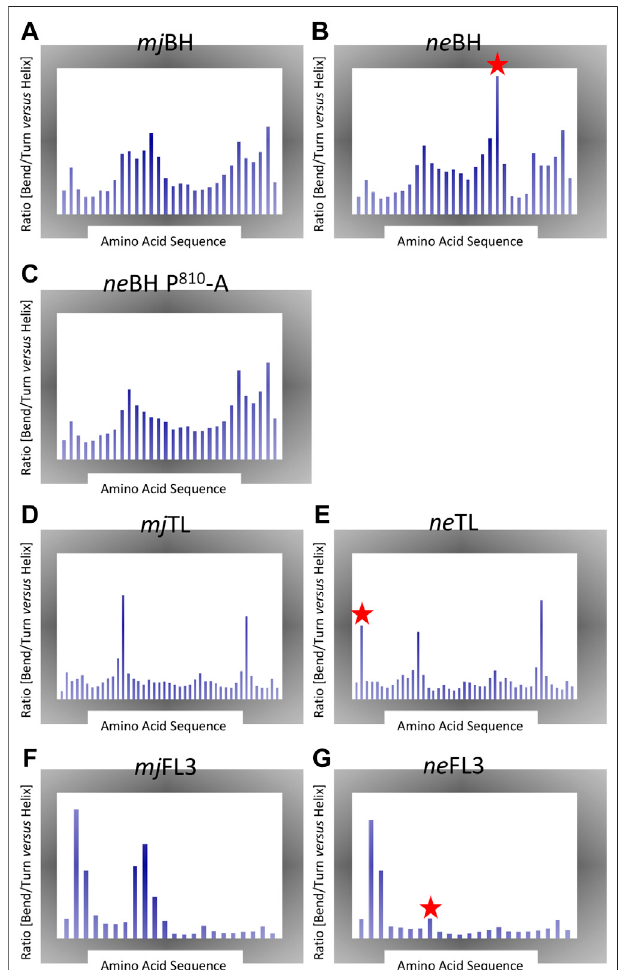
FIGURE 3 | Markov Chain Monte Carlo (MCMC). Each plot shows the ratio of percentage of disordered secondary structure elements (bends, turns) vs. percentage ofhelical structures (including a -, 3 – 10and p helixdata) created during the simulations. Large peaks therefore highlight regions displaying local structural instability. The x -axis shows the amino acid positions for each element.Note thatthe range of y -axes isvariablebetween different plotgroups. Signi fi cantlocal structuralvariations present inthe ne motifsare highlighted with a red star (A) Bridge Helix from M. jannaschii (B) Bridge Helix from N. equitans (C) Bridge Helix from M. jannaschii simulated with in silico mutated ne A ′ P 810 -A (D) Trigger Loop from M. jannaschii (E) Trigger Loop from N. equitans (E) Fork Loop 3 from M. jannaschii (F) Fork Loop 3 from N. equitans